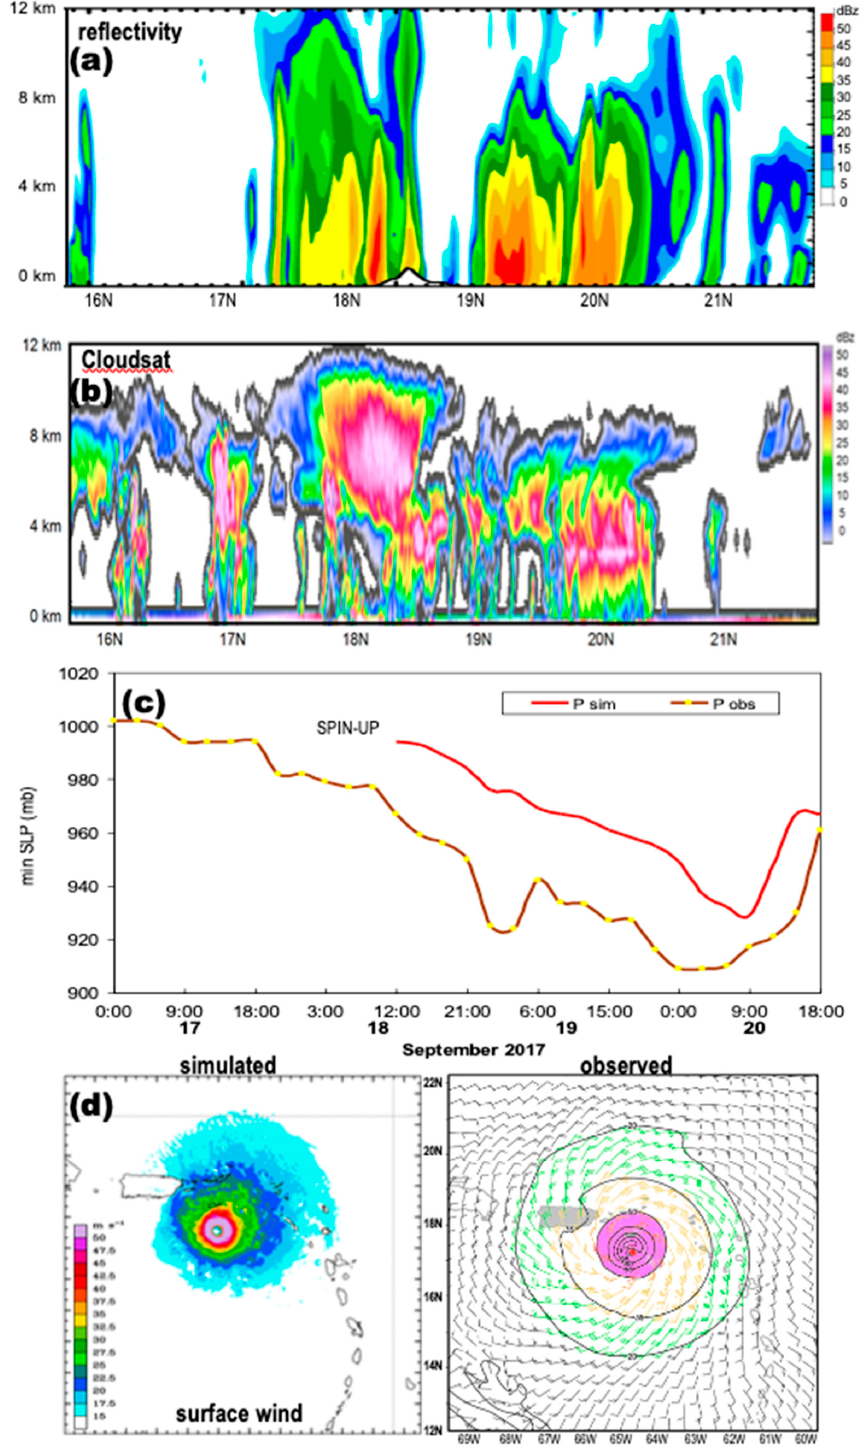
Figure 10. Vertical N-S sections on 66.5W longitude at 18Z September 20 2017 of ( a ) PR-area WRF +84 h forecast radar reflectivity, and ( b ) Cloudsat reflectivity (scales vary). ( c ) PR-area WRF simulated and NHC observed minimum pressure (cf. Table 1). ( d ) Surface wind maps at 03Z 20 September: PR-area WRF simulation (left) and CIRA-NHC hindcasts (>50 m/s pink shaded).